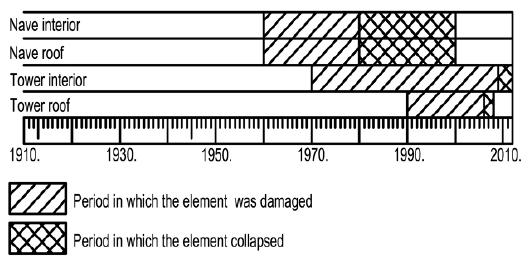
Figure 1. Timeline presenting the level of damage.